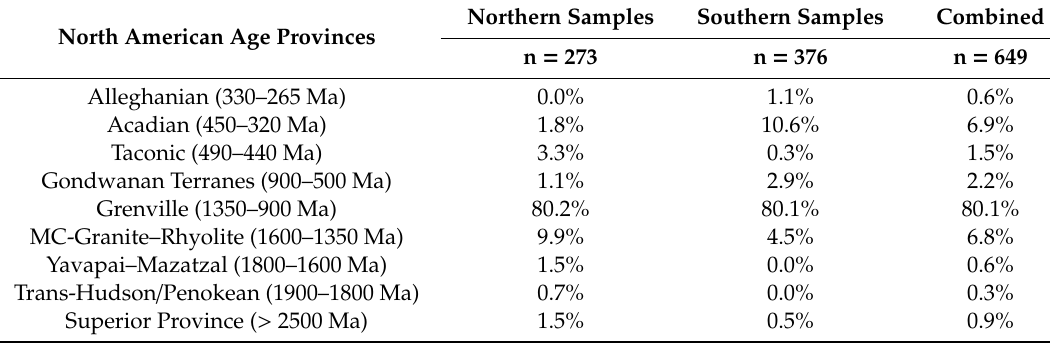
Table 1. North American igneous province age distribution and percentages for the northern sample population (NS) and southern sample population (SS).